Question: Express in one sentence what the figure is showing.
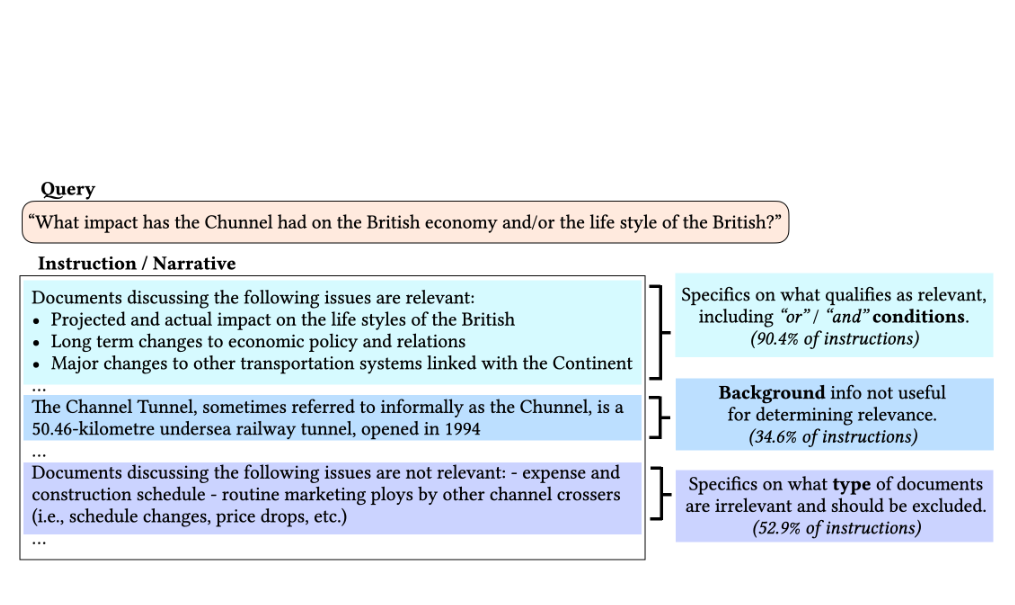
Answer: How do standard retrieval queries differ from instructions (or narratives)? Instructions contain more specific details about what is relevant, include less directly-relevant background information, and often have directives about what documents are not relevant, using negation. %’s are how often a certain type of content appears in the original TREC instructions used in FOLLOWIR.